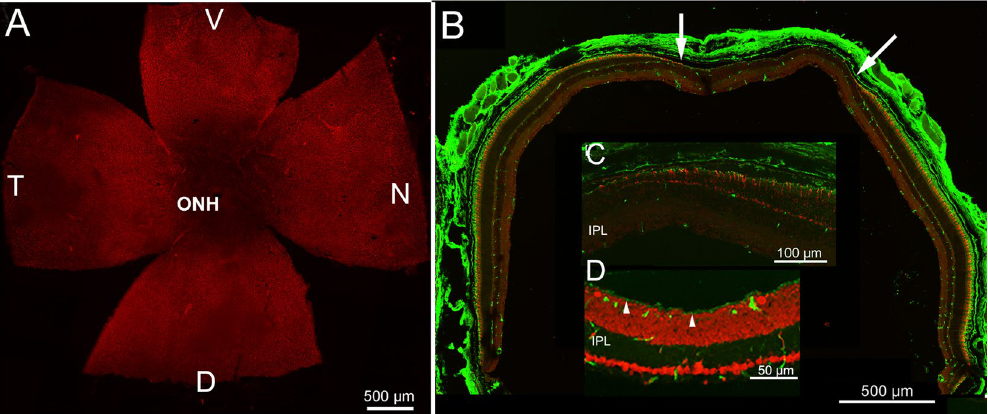
Figure 7. Long-term effects of phenotype induction. Whole mount retinas exposed for 1 min to 12,000 lux and examined after 30 days. ( A ) Focus on cone outer segments, stained red by cone opsin antibodies, show that the central, dark area, has decreased compared to what shown in Fig. 3A. ONH: optic nerve head. ( B ) Vertical section of an eye cup from a Tvrm4 mouse similar to that shown in A. Cone arrestin (red) and rhodopsin staining (green) show that the photoreceptor-free zone (between the white arrows) remained restricted to the central retina, similarly to what shown in Fig. 2A. ( C ) Cone progressive shortening toward the central retina (on the left side of the picture), where a faint rhodopsin staining becomes visible. ( D ) Light sensitive channel (green) highlights punctuate staining in the outer retina (arrowheads), likely corresponding to re-growing outer segments of rods. Red: ethidium nuclear counterstaining.